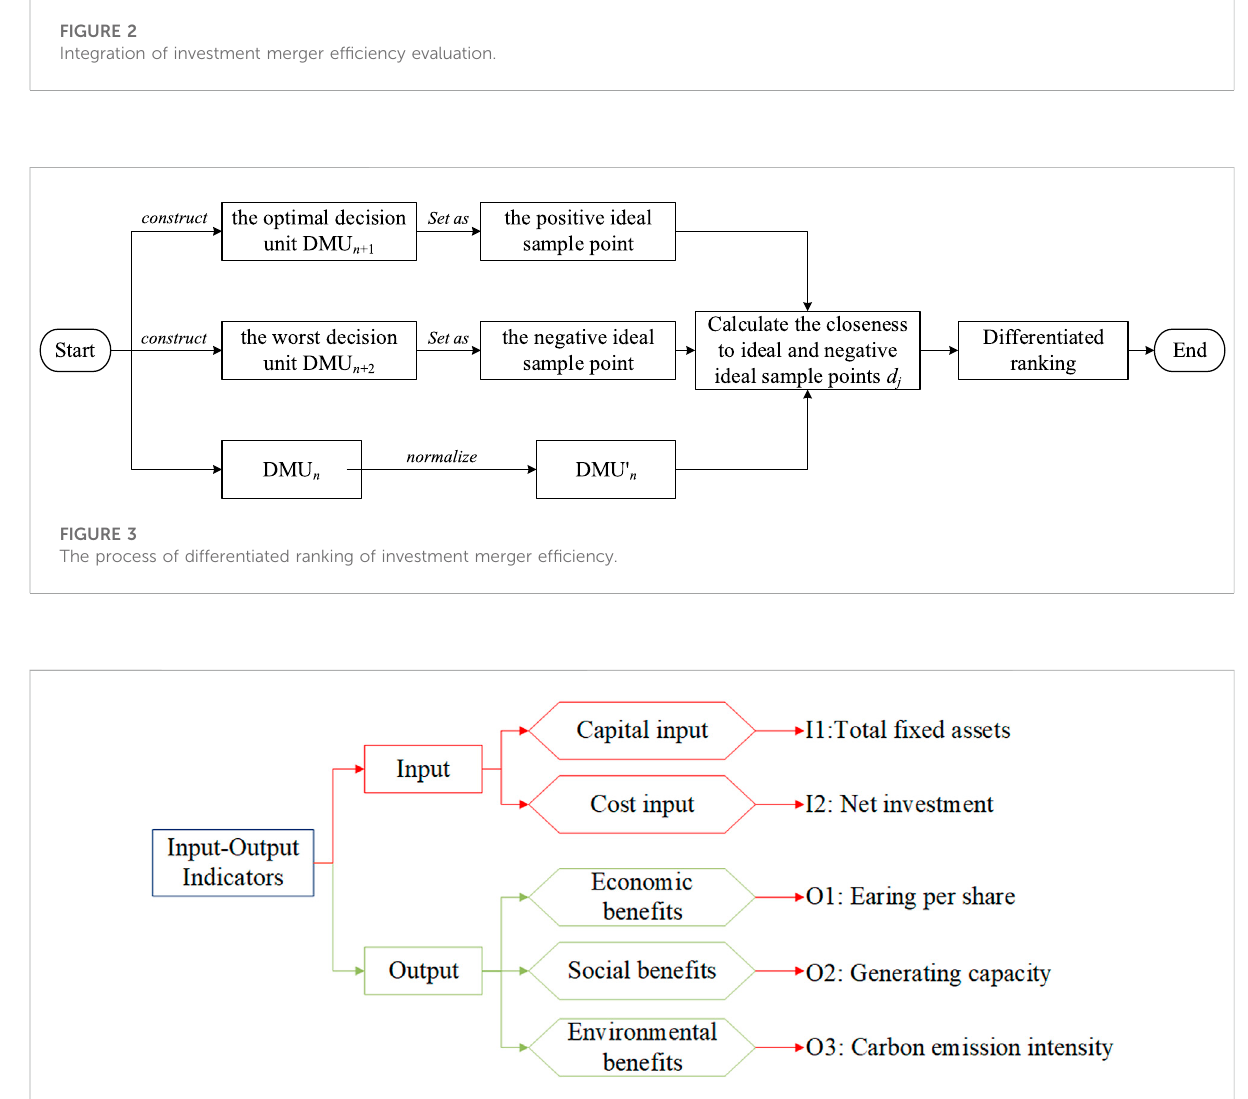
FIGURE 4 Final index system of investment and merger of energy Internet power